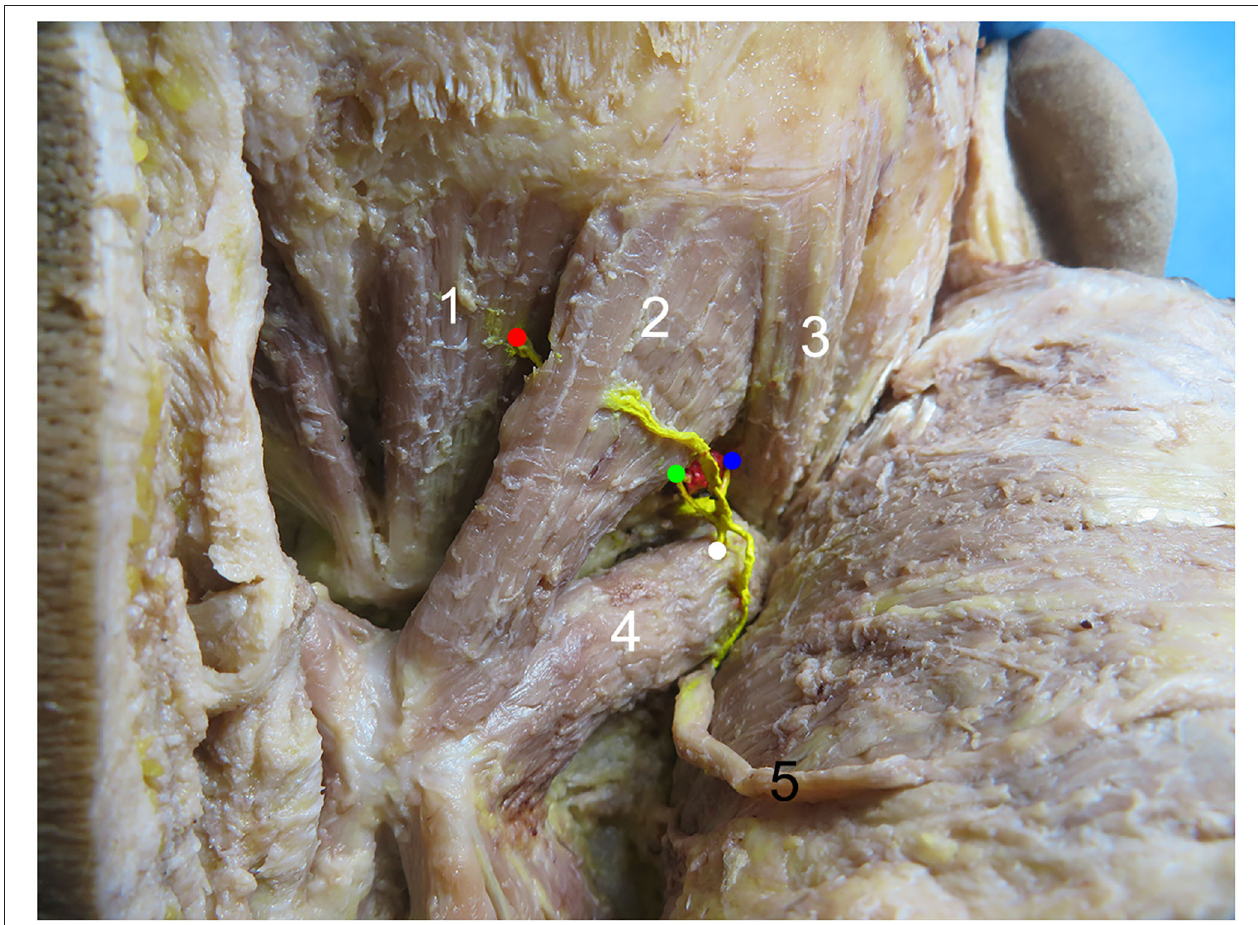
FIGURE 1 | Common types of right suboccipital nerve entry points. 1, Rectus capitis posterior minor muscle. 2, Rectus capitis posterior major muscle. 3, Obliquus capitis superior muscle. 4, Obliquus capitis inferior muscle. 5, Greater occipital nerve. The red, green, blue, and white dots represent the nerve entry points of the rectus capitis posterior minor, rectus capitis posterior major, obliquus capitis superior, and obliquus capitis inferior muscles,